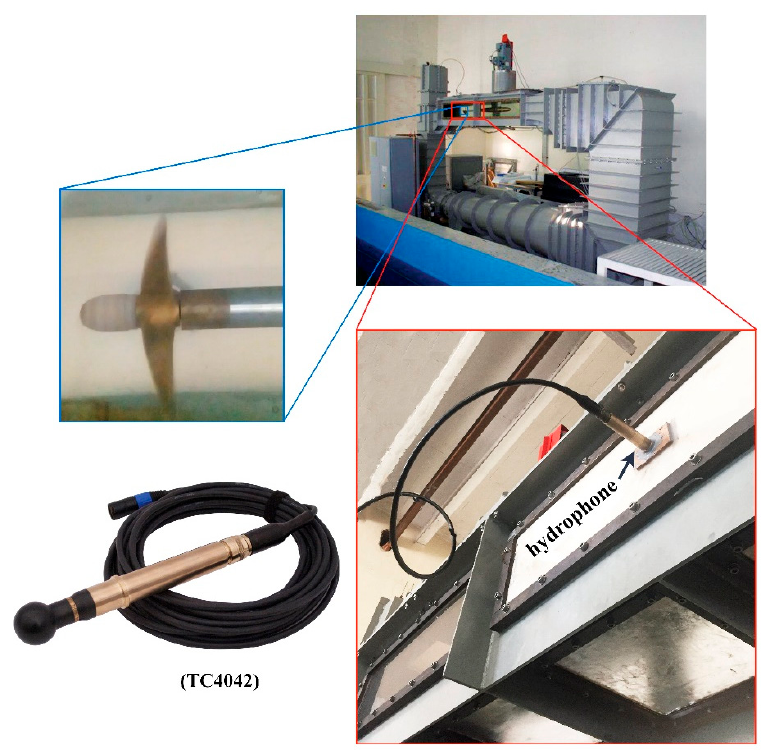
Figure 10. Arrangement of TC4042 hydrophone on cavitation tunnel.